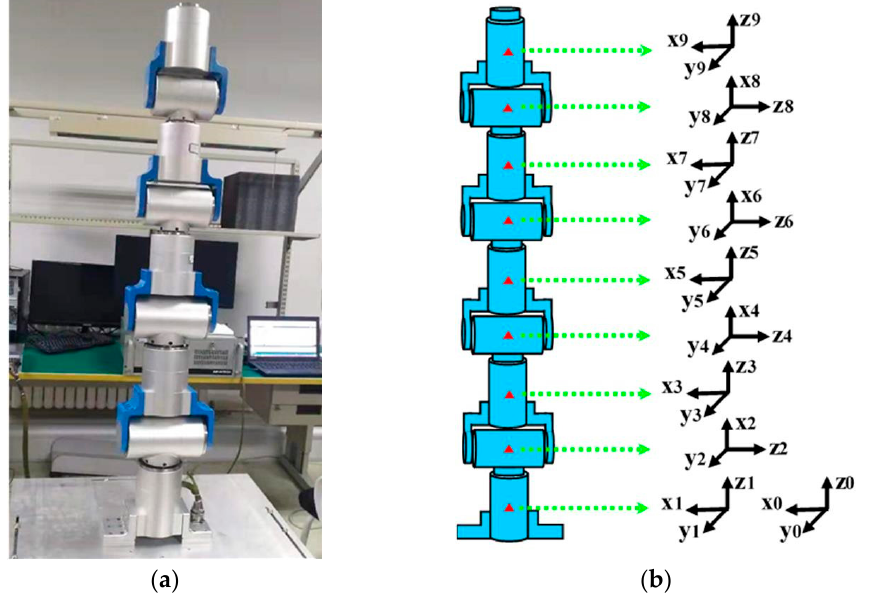
Figure 6. The correlogram of 9-DOF hyper-redundant manipulator. ( a ) Structure of the manipulator; ( b ) Establishment of coordinate system. Table 1. The parameter table of screw modeling.